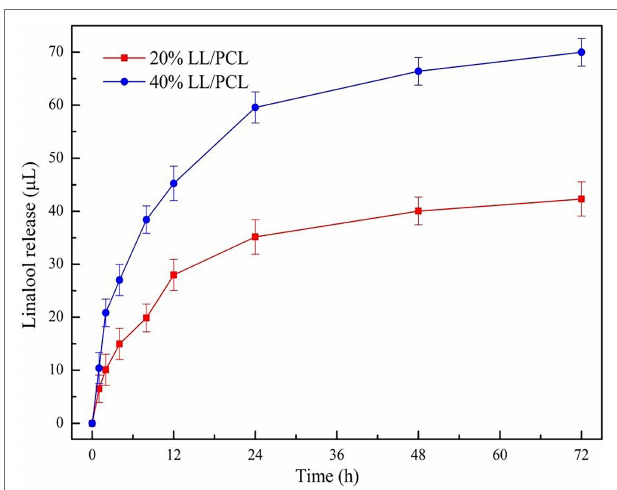
FIGURE 5 | Release curves of LL/PCL fibrous membranes.